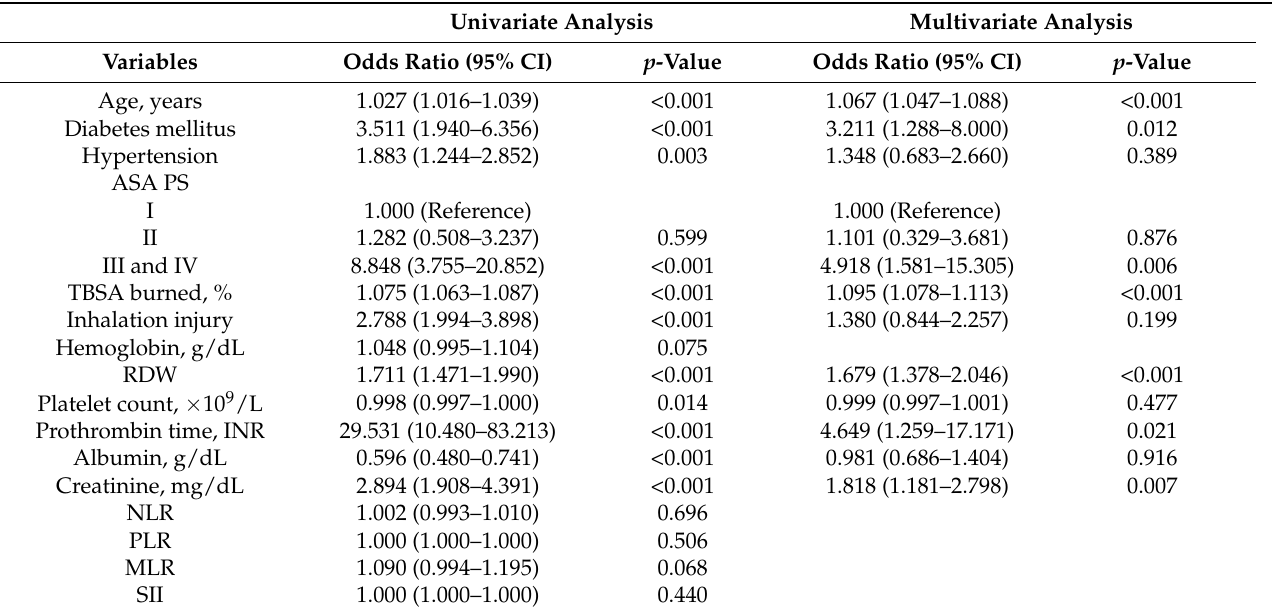
Table 2. Univariate and multivariate analyses for evaluating the risk factors of mortality after burn